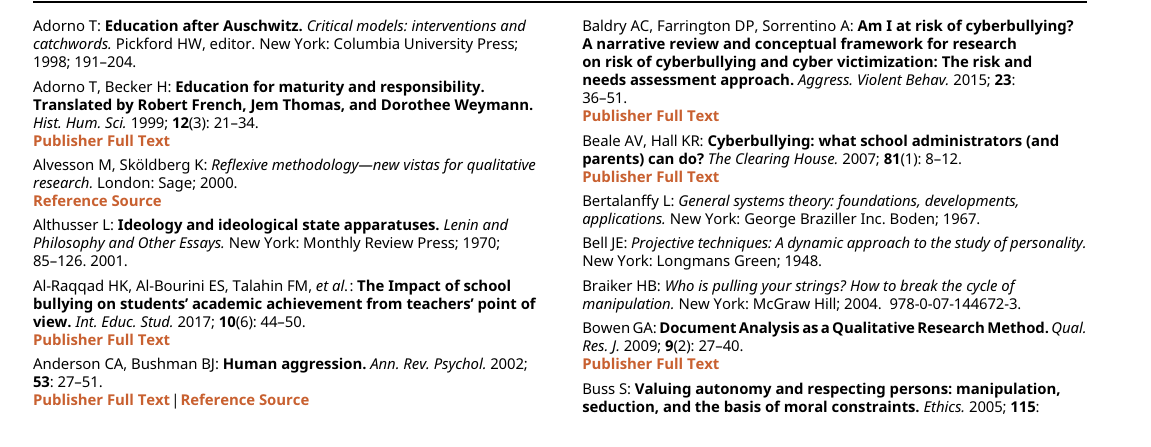
Figshare: A model of coercive control in higher education: a qualitative study. https://doi.org/10.25399/Unisa- Data.20120627.v3 (Jakovljevic,